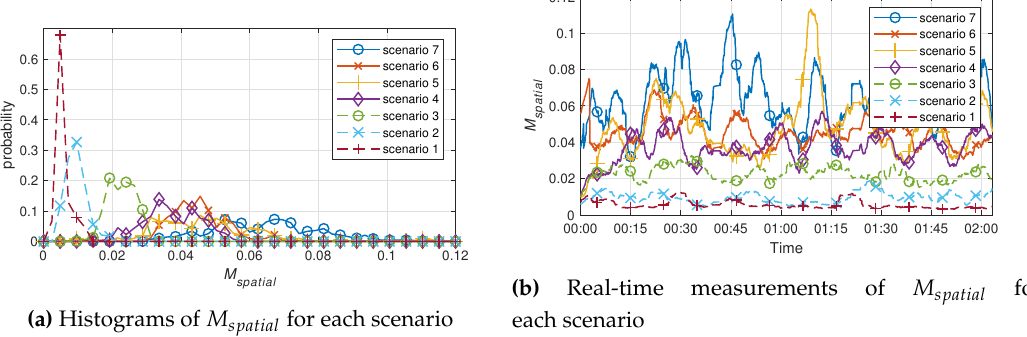
Figure 4. Experiment results of the spatial movement index, M spatial , for each